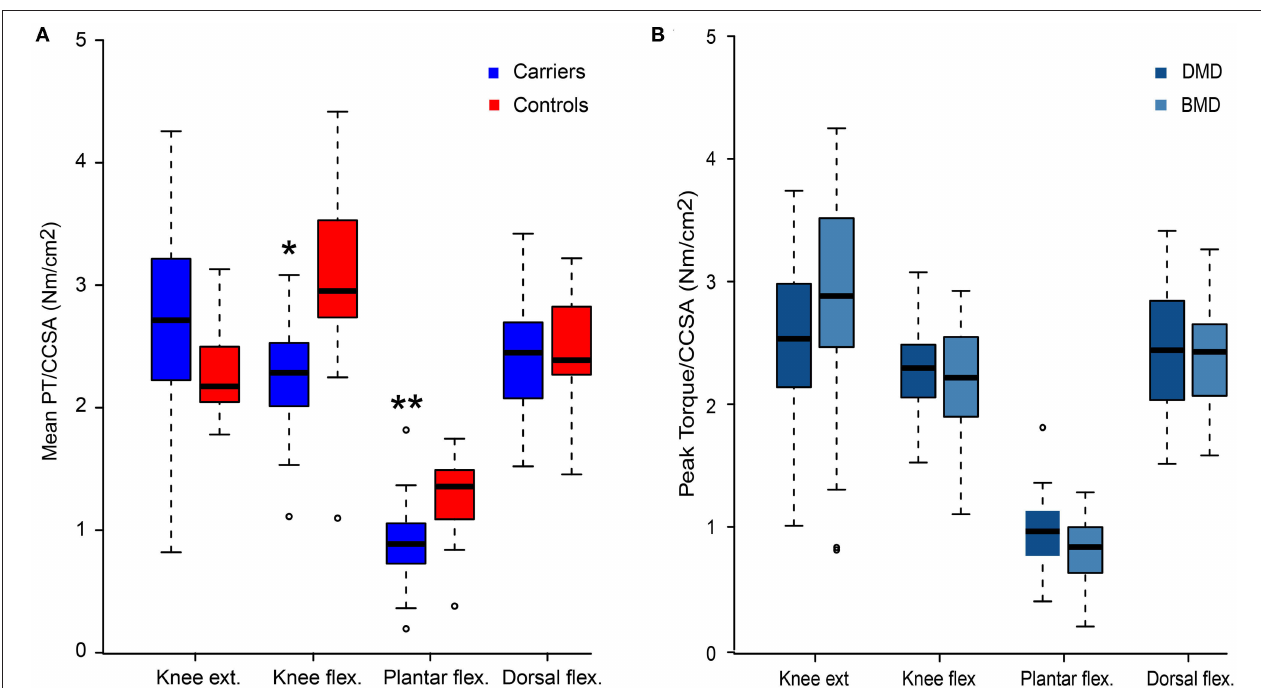
FIGURE 3 | Peak torque/contractile cross-sectional area. Peak torque/CCSA values for women with pathogenic variants in DMD compared to healthy women (Controls) (A) , and comparison of peak torque/CCSA values in women with variants predicted to result in Duchenne muscular dystrophy (DMD) and Becker muscular dystrophy (BMD) (B) . Presented as median value and four quartiles. CCSA, contractile cross-sectional area; ext, extension; flex, flexion; * p < 0.05 and ** p < 0.001 vs.